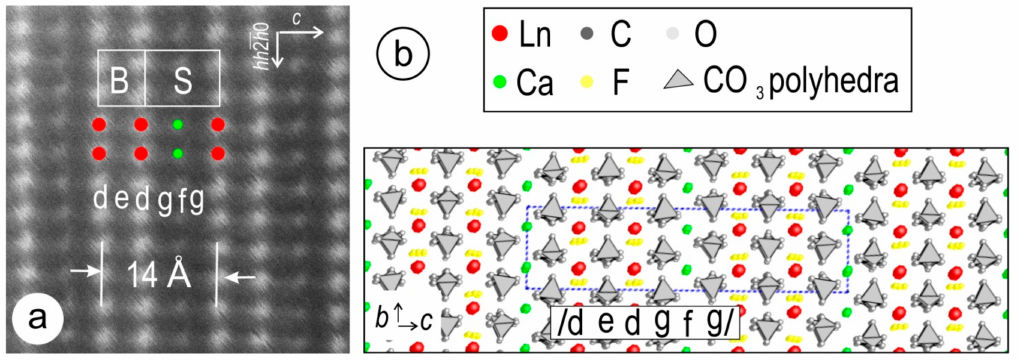
Figure 7. Interpretation of the ‘stacking code’ for BSG compounds with both Ln and Ca layers as imaged in HAADF STEM mode. ( a ) Atomic-scale image of parisite viewed down to [ − 1100] zone axis with superimposed atoms and layers as marked; ( b ) Crystal structure of parisite (after Ni et al. [23]) showing the correspondence to the stacking layers. Unit cell marked in blue. The orientation (viewed down to a axis) is chosen so that the arrays of atoms correspond to the orthogonal lattice shown in ( a